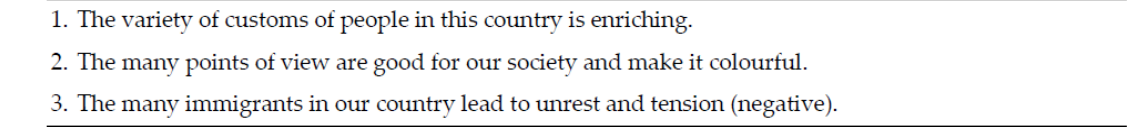
Figure 5. Dimensions of the concept of ‘cultural and religious diversity’.